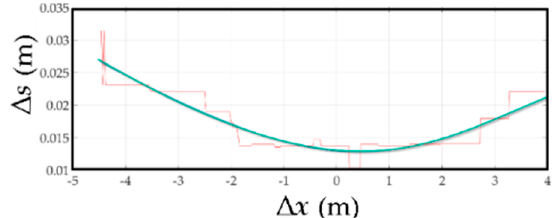
Figure 10. Using a weighted least-squares method to fit a curve to the data of ∆ s and ∆ x .